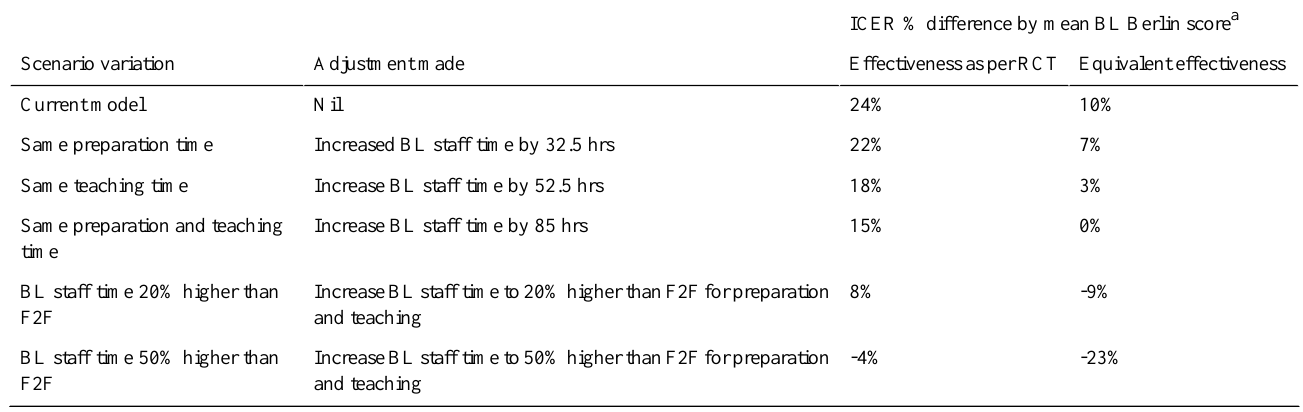
Table 4. Multivariate sensitivity analysis adjusting staffing levels and mean BL Berlin score.